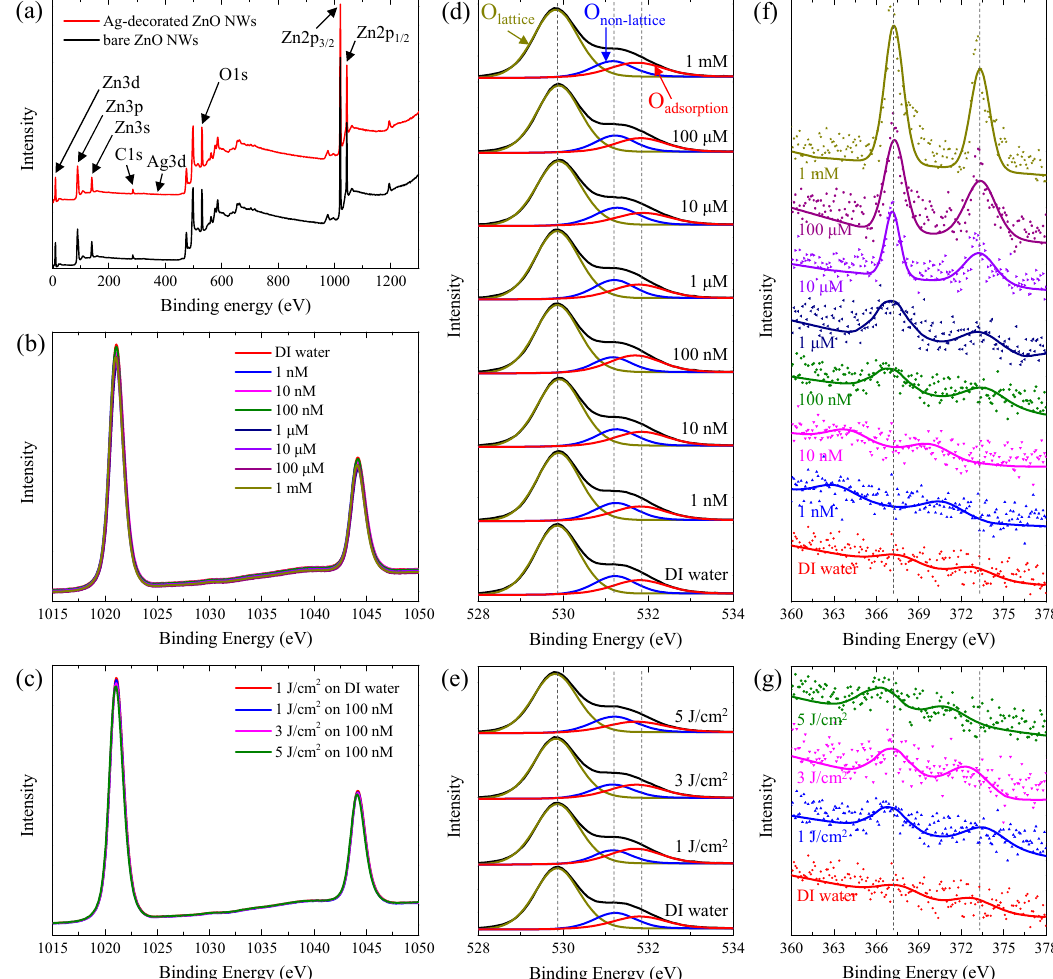
Figure 4. XPS of the bare and Ag-decorated ZnO NWs: ( a ) survey; ( b , c ) Zn 2p spectrum; ( d , e ) O 1s spectrum; and ( f , g ) Ag 3d spectrum. ( b , d , f ) Plots at different concentrations, ( c , e , g ) plots at different IPL irradiation energies.